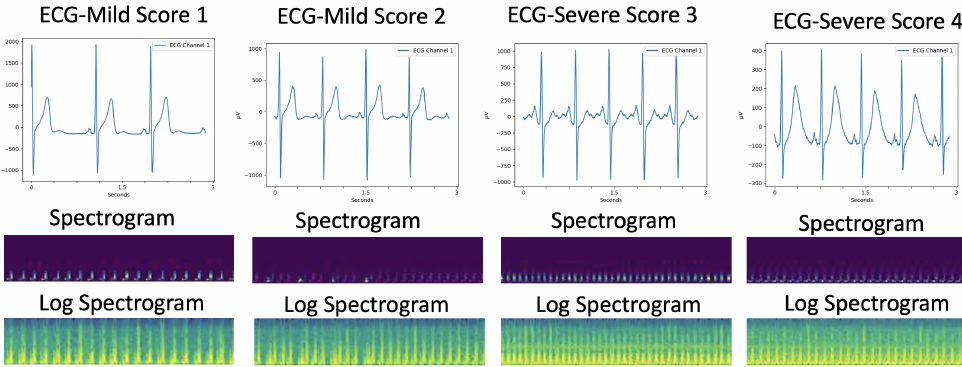
Figure 2. Examples of ECG waveforms collected from tetanus patients, spectrograms and normalised log-spectrograms generated for each tetanus classification: scores 1 and 2 refer to mild symptoms and scores 3 and 4 refer to severe symptoms.